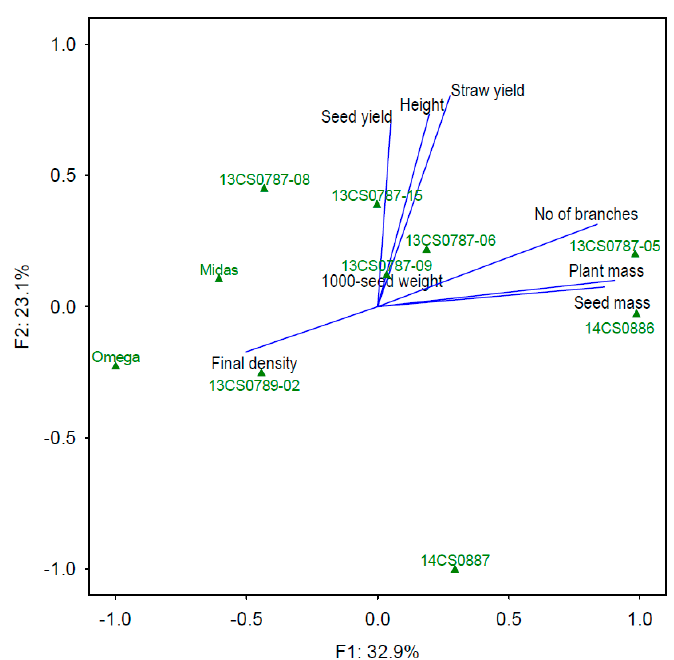
Figure 2. The biplot of the relationship between all traits and 10 spring camelina genotypes (triangles) across four experimental years (2015–2018).